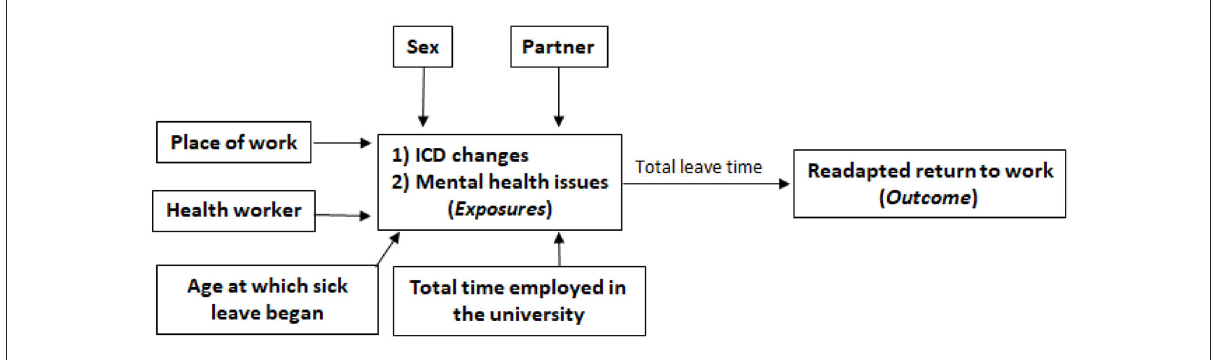
FIGURE1 Inferential model to be adjusted by LR and TMLE.